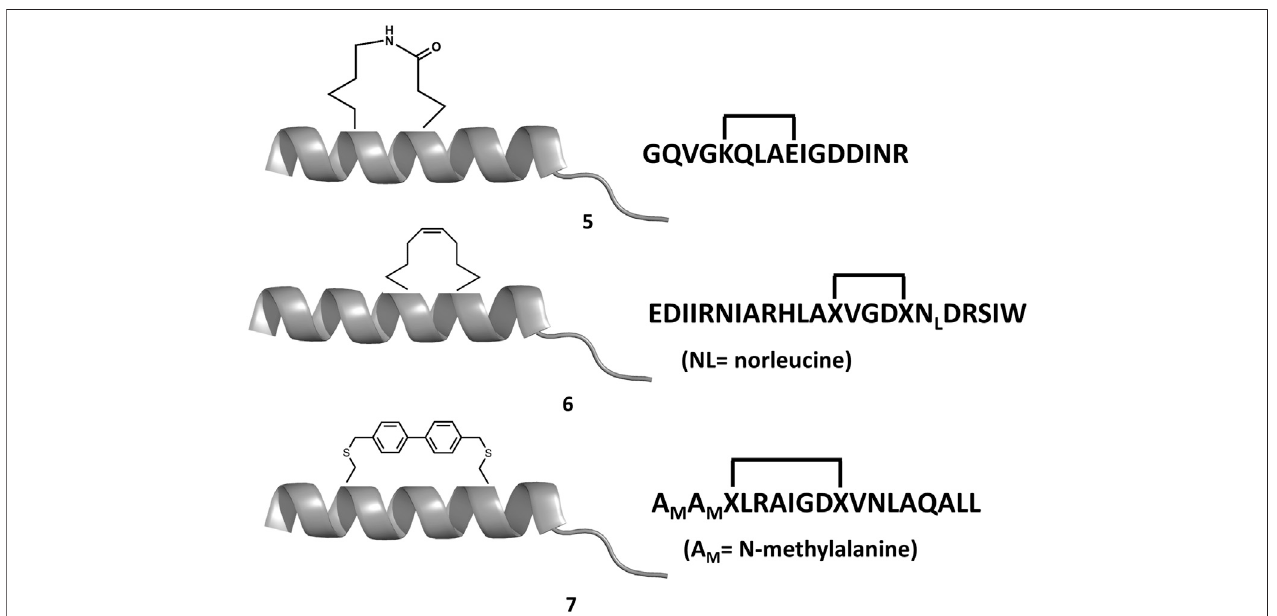
FIGURE 6 | Chemical structures of diverse stapled analogs of the BH3